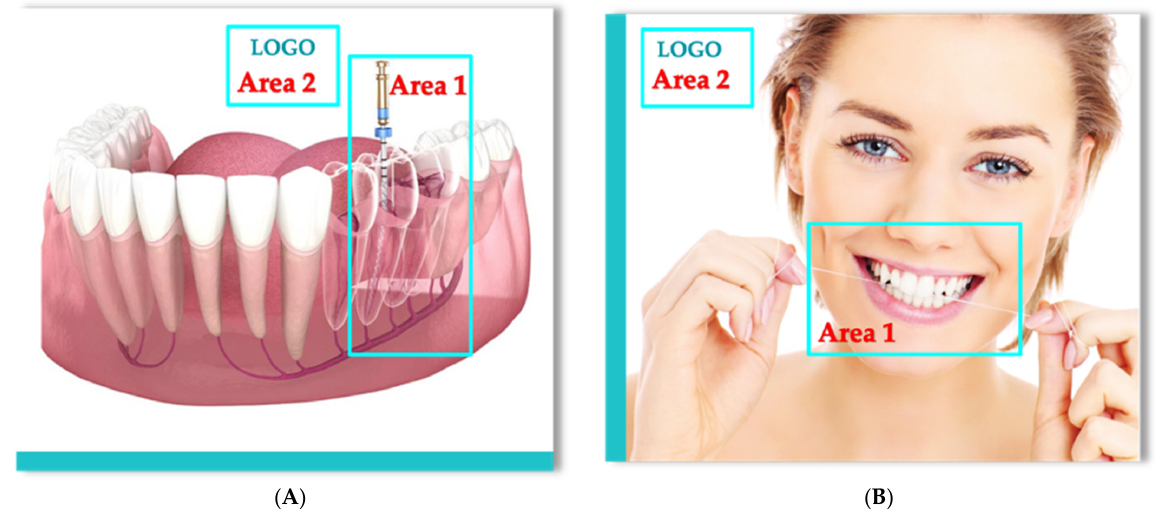
After completing the experiment, two areas of interest could be identified in each